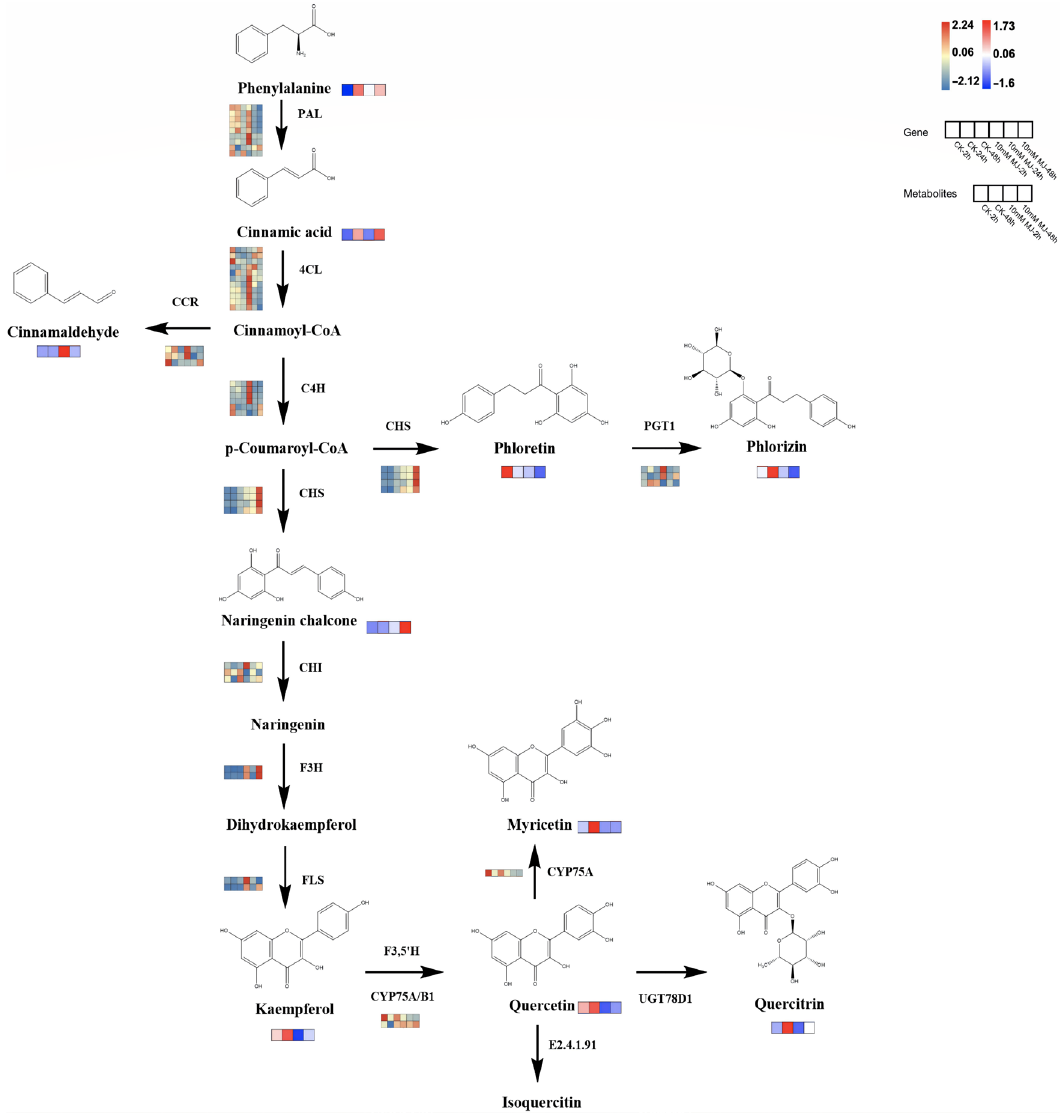
Figure 7. Proposed biosynthetic pathways of flavonoids in C. vietnamensis. Blue–yellow–red repre- sents transcripts from downregulated to upregulated, and blue–white–red represents metabolites from downregulated to upregulated.